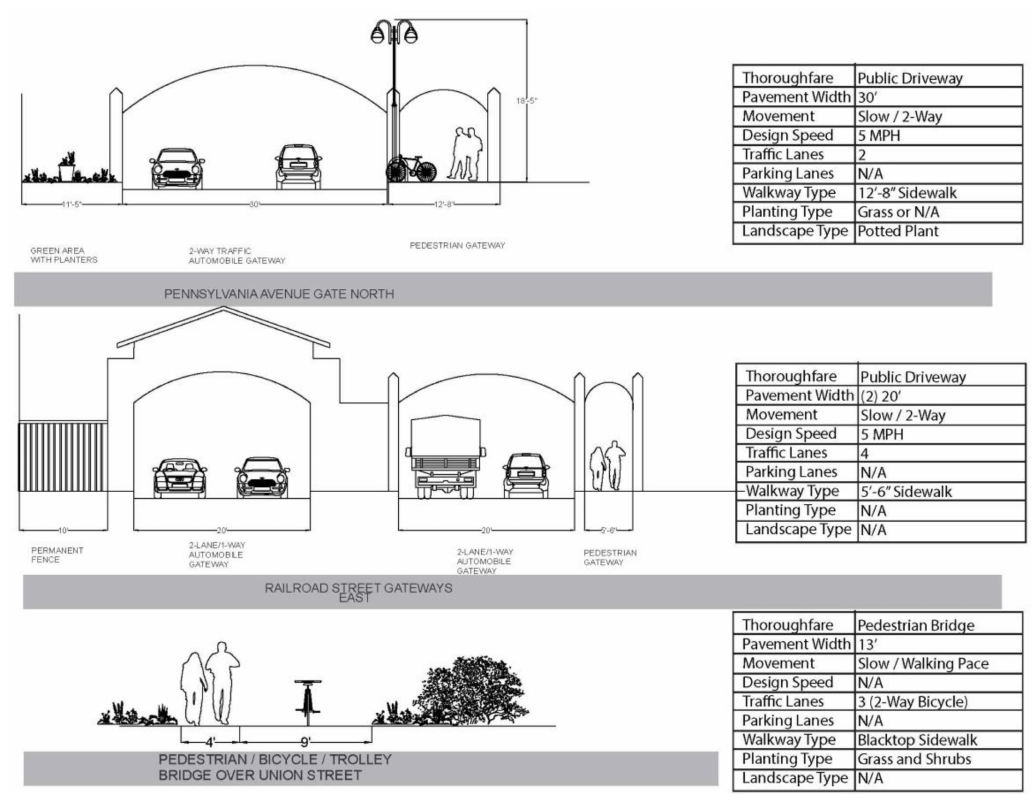
Figure 8. Public Market street sections (by